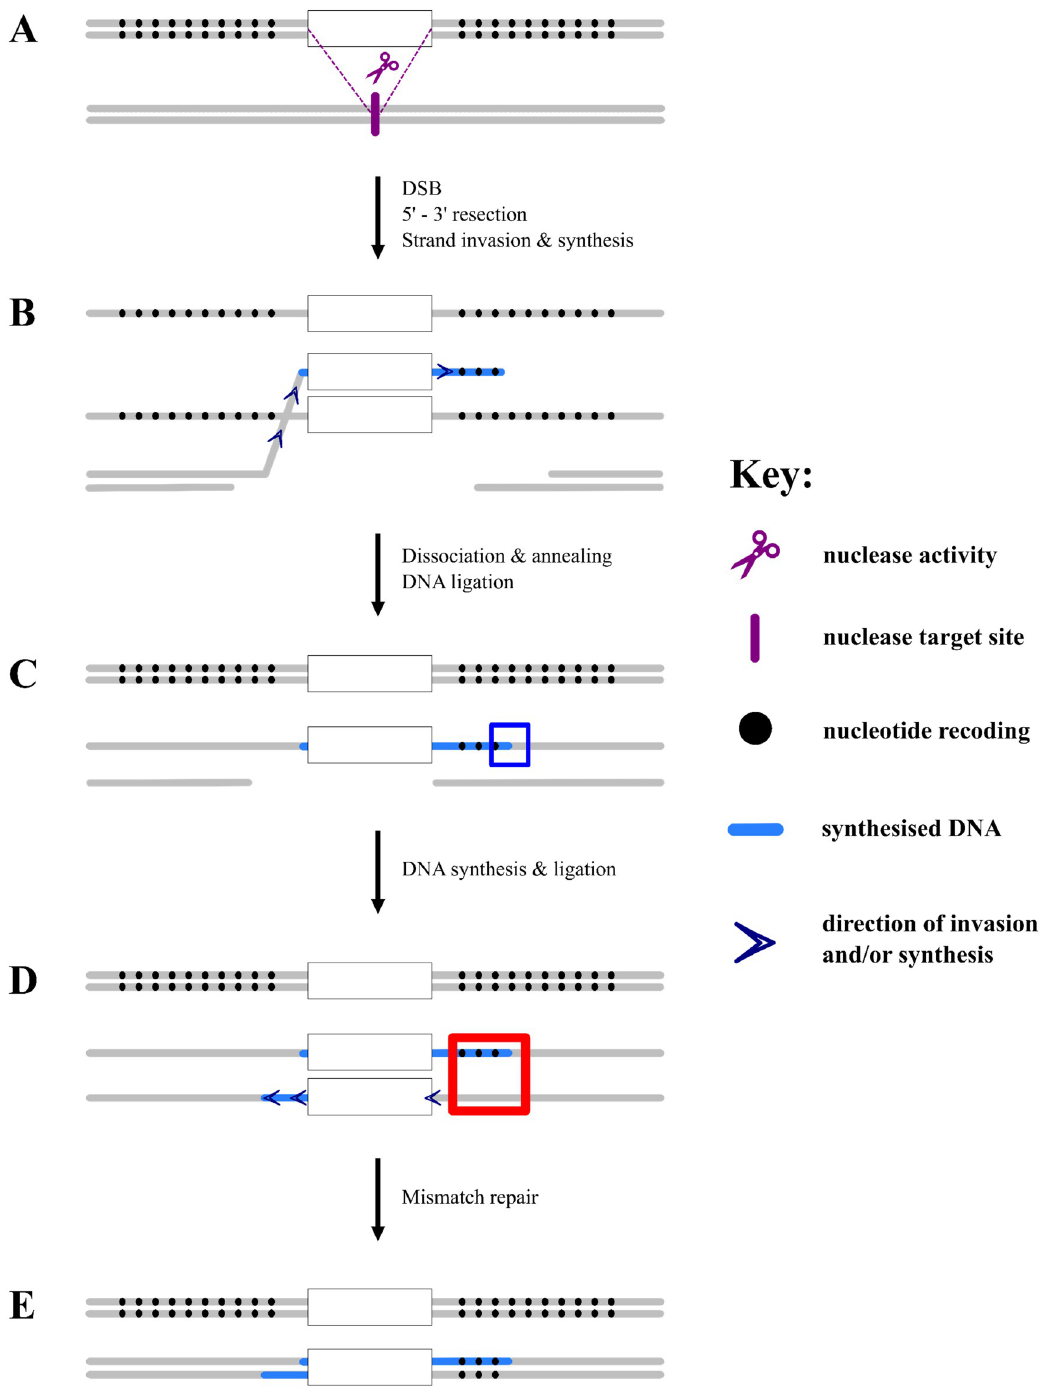
Fig 4. Proposed mechanisms of synthesis-dependent strand annealing (SDSA) and mismatch repair. (A) Double-stranded break caused by Cas9 is followed by 5’–3’ resection of the broken ends, leaving 3’ overhangs which will search for homology to initiate repair. (B) One of the overhanging strands finds homology in the donor and invades very closely to the homology arm- transgene junction, thereby bypassing the recoding on this side of the homology arms. The invading strand synthesises DNA using donor sequences as a template. (C) When this newly synthesised strand recognises homology on the 3’ overhang of the other end of the DSB, it dissociates from the template, anneals to the 3’ overhang, and is ligated to the 5’ end of one of the previously resected strands (squared in blue). (D) The other strand now repairs its break by DNA synthesis and ligation using the invading strand as its template, forming a heteroduplex region (squared in red). (E) Finally, the heteroduplex region is resolved by the mismatch repair pathway which favours the invading strand over the non-invading